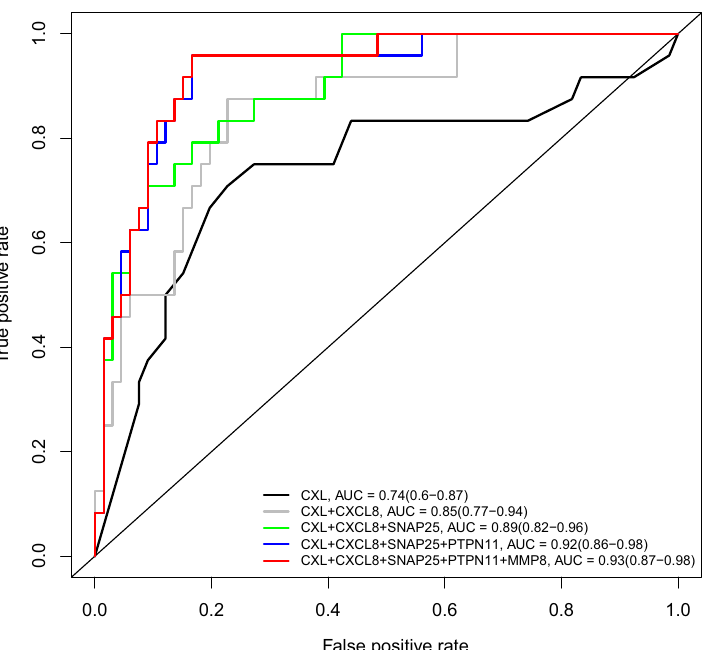
Figure 3. Combinations of multiple proteins for improving prediction of imminent delivery. AUC: area under the ROC curve and 95% confidence interval. CL: cervical length.